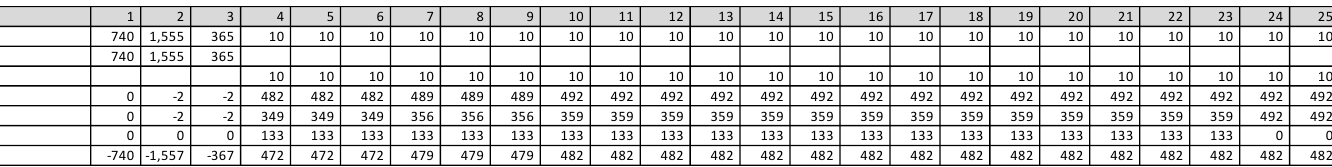
Figure 5. Cash flow of typical three mil ton/year steel project ($M USD).